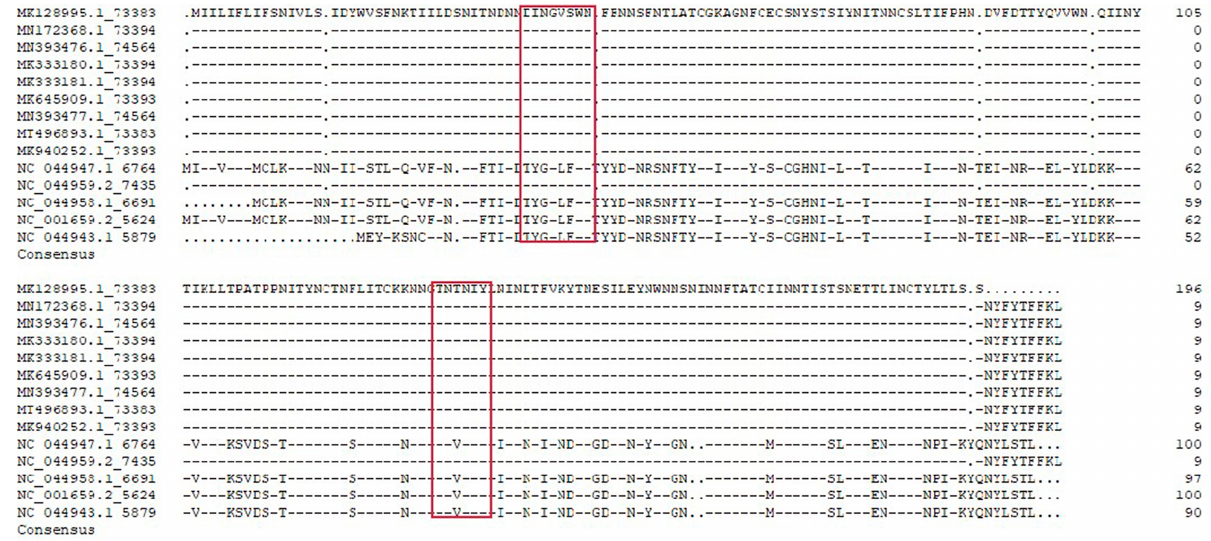
Figure 5. Conservative analysis of the defined epitope sequences.